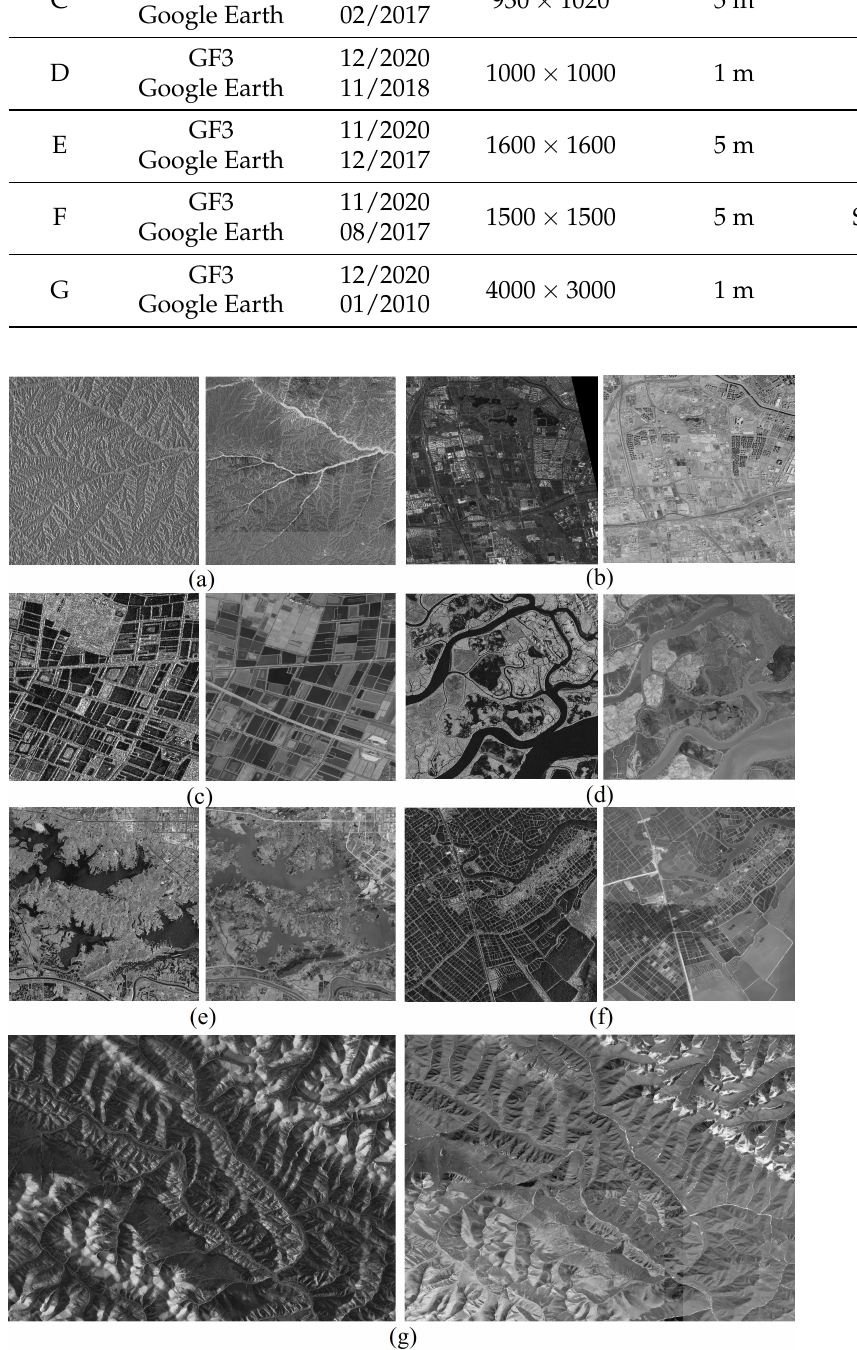
Figure 16. Experimental images. ( a – g ) are pair A–G in Table